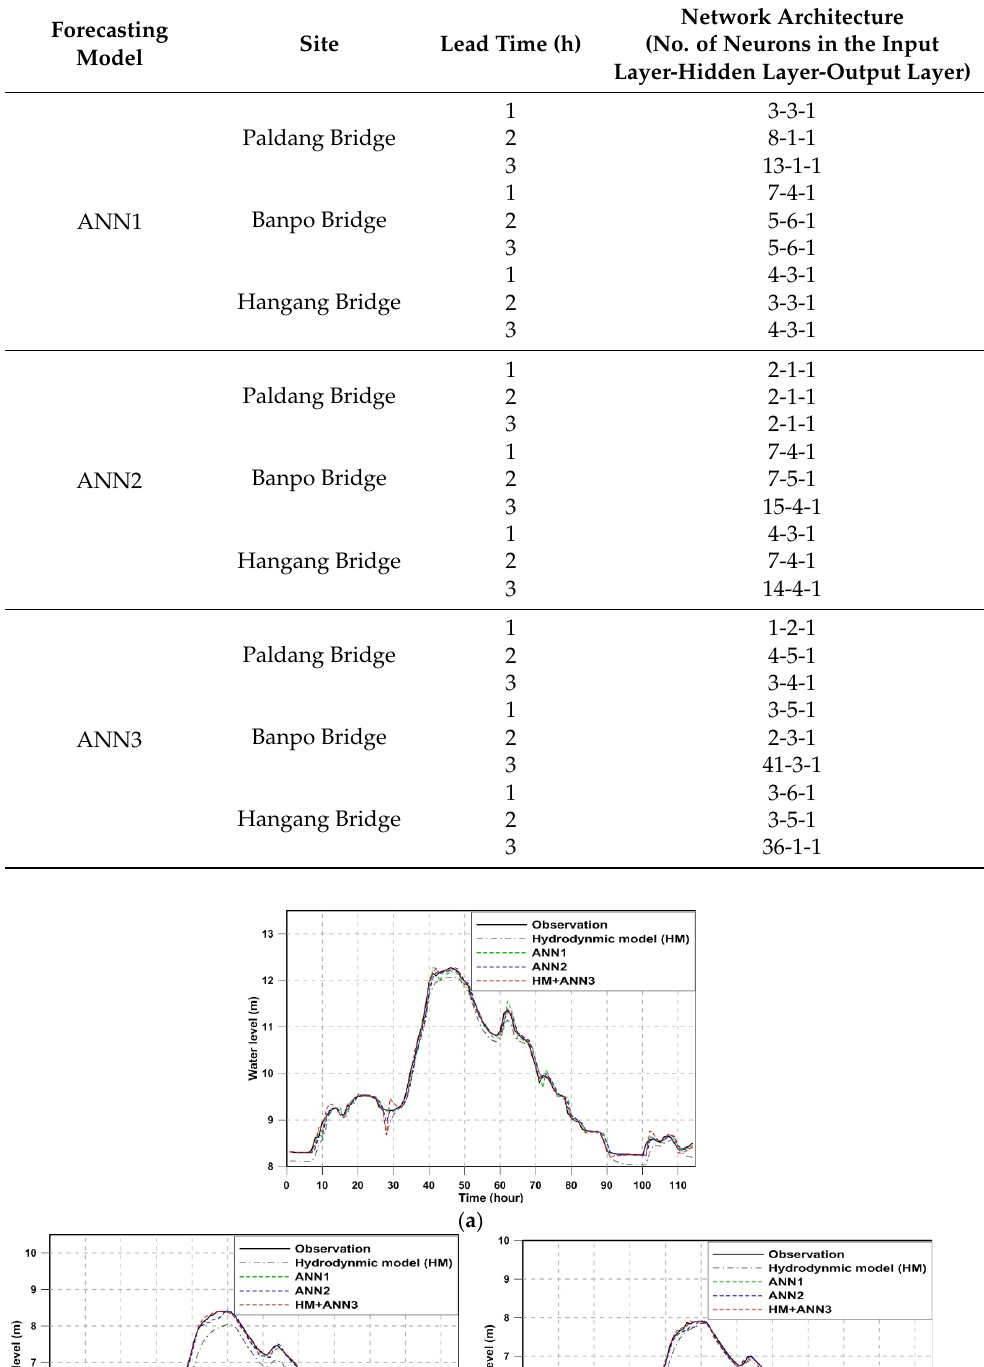
Table 5. Network architectures for different sites at different lead times.